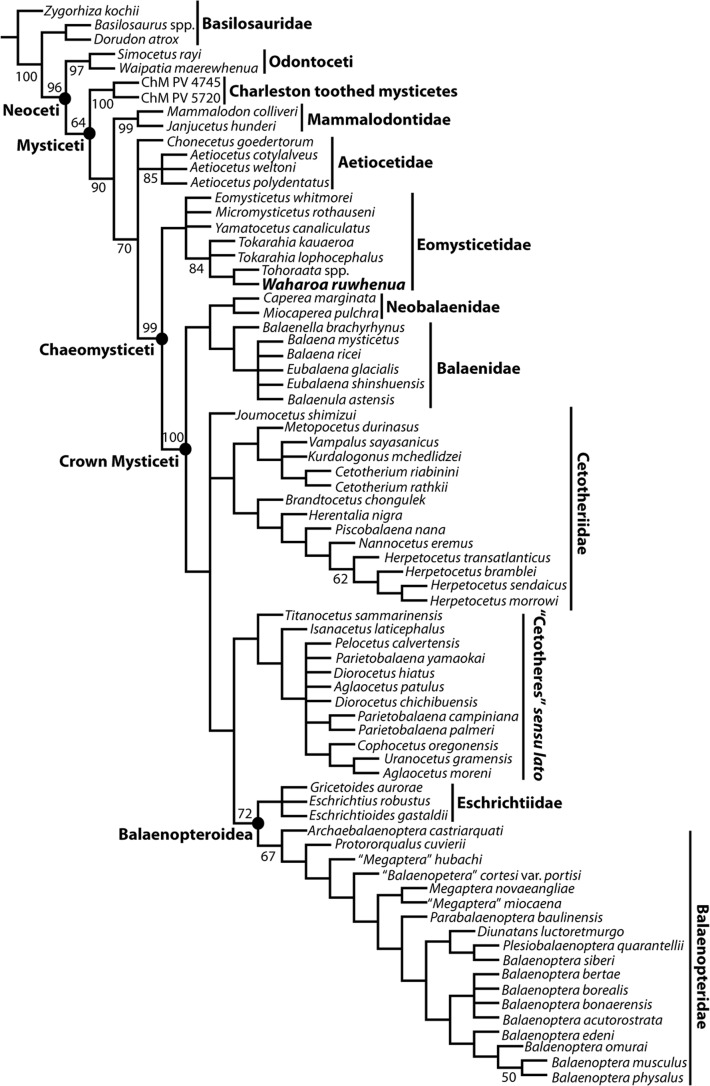
Phylogenetic relationships of Waharoa ruwhenua.(A) strict consensus of 88 equally parsimonious trees (1,417 steps, CI: 0.361, RI: 0.812) recovered under equal weighting with bootstrap support values included. (B) single most parsimonious tree (122 steps, CI: 0.357, RI: 0.808) recovered under implied weighting, with bootstrap values included.